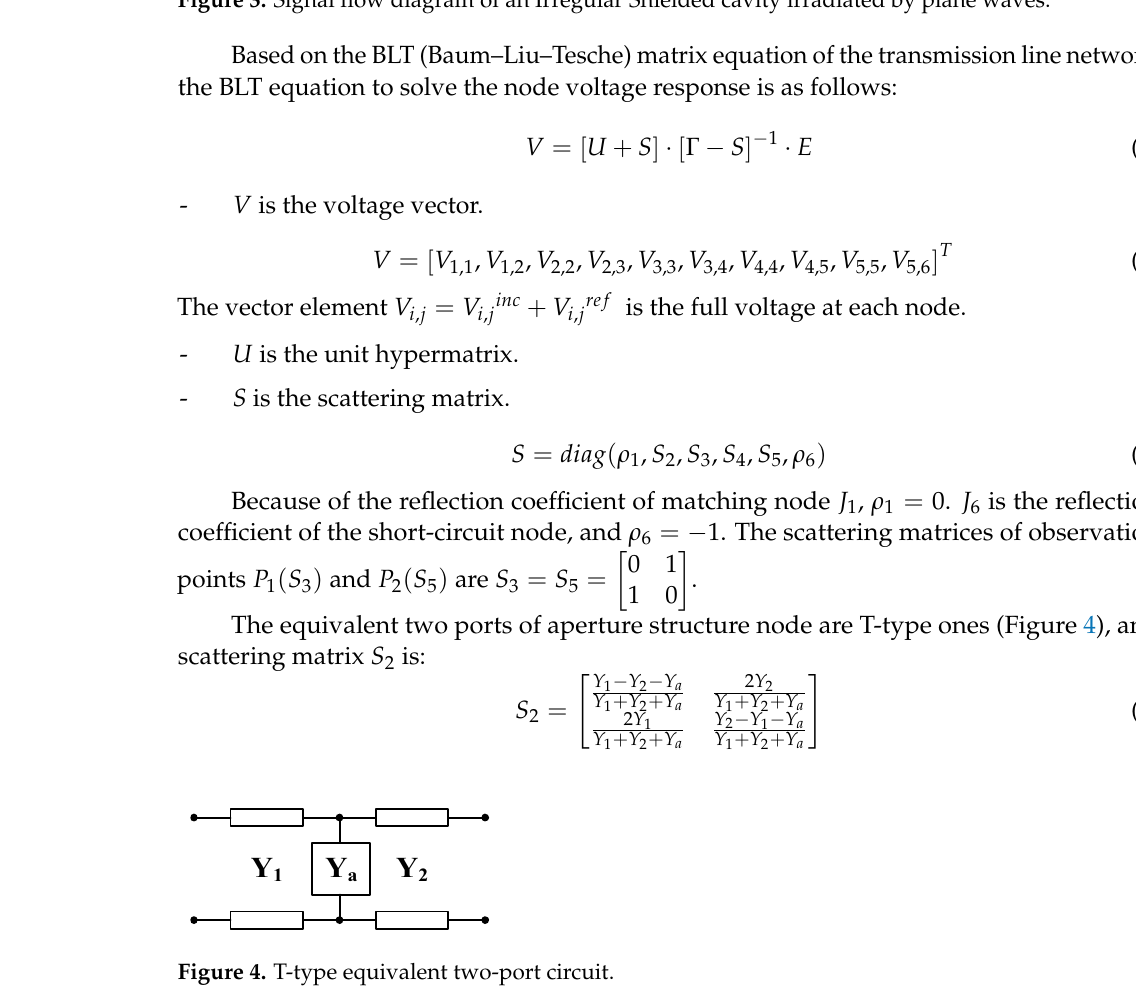
Y a Figure 5. Π-type-equivalent two-port circuit. 2.2. Irregular Cavity Classification Based on the classification of irregular cavities in the electromagnetic topology the- ory, irregular cavities are typically divided into six types, as shown in Figure 6. When the electric field is perpendicular to the long side of the aperture, the most common irregular structures or a combination of the above six structures are covered.